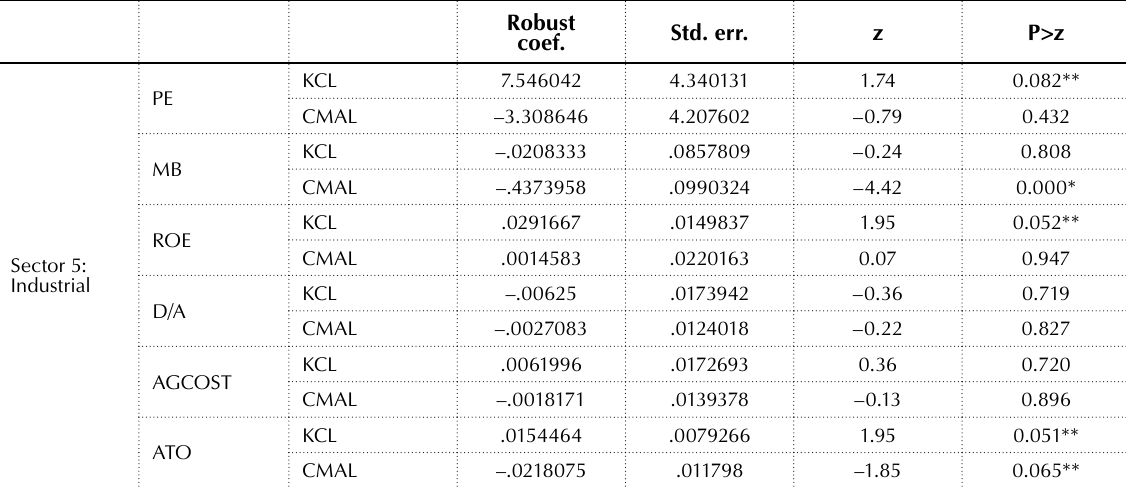
Table 11. GLS panel data regression for the industrial sector